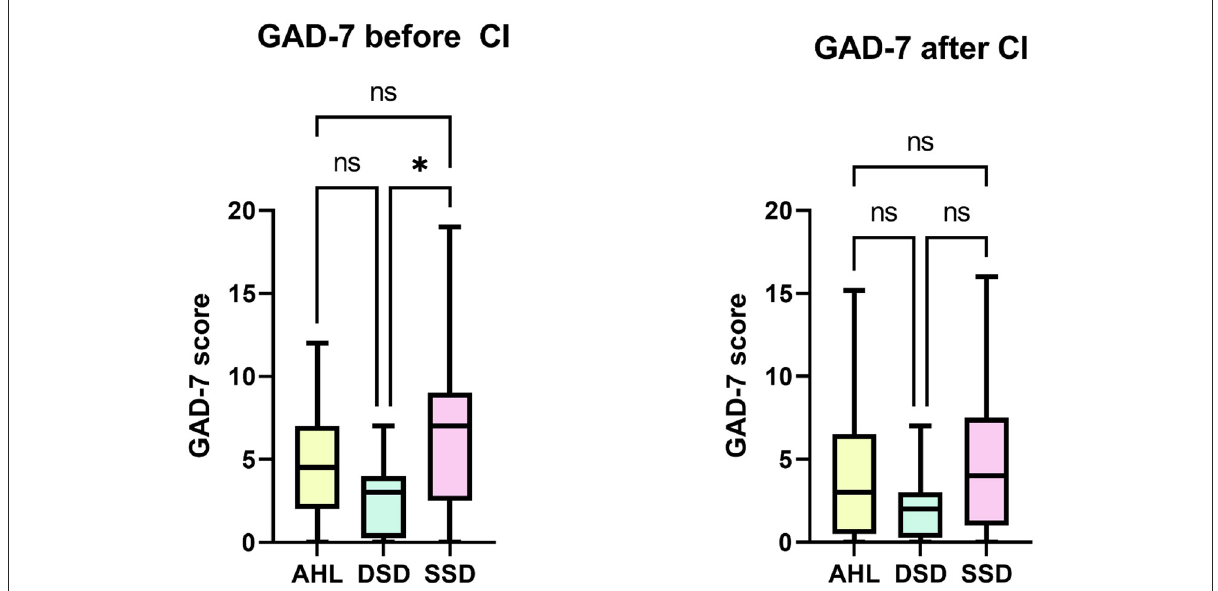
FIGURE6 Between-group differences in the anxiety symptoms (GAD-7). Kruskal-Wallis test indicated a significant difference between the DSD and SSD groups at the study onset. After implantation, there were no longer differences between the groups. * p < 0.05; ns, not significant.